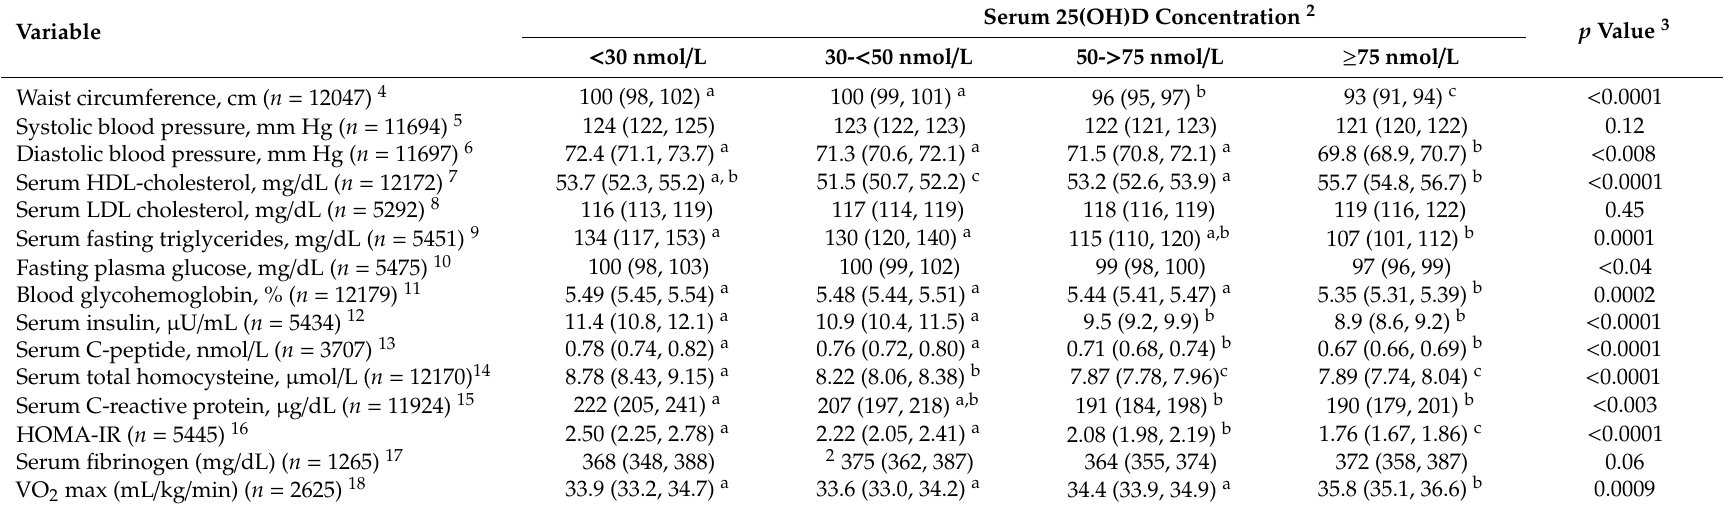
Table 4. Concentrations of cardiometabolic biomarkers according to the clinical cut o ff serum 25-hydroxyvitamin D [25(OH)D] concentrations in US adults: National Health and Nutrition Examination Surveys (NHANESs), 2001–2006 1